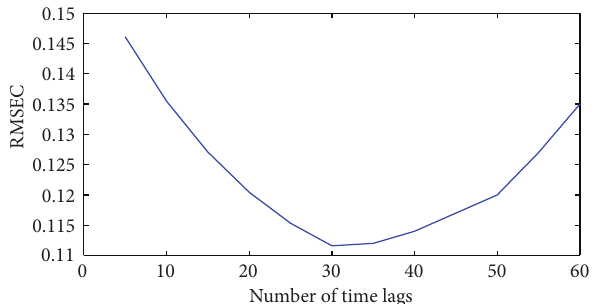
Figure 8: The RMSEC for different numbers of time lags of the DPLS algorithm.